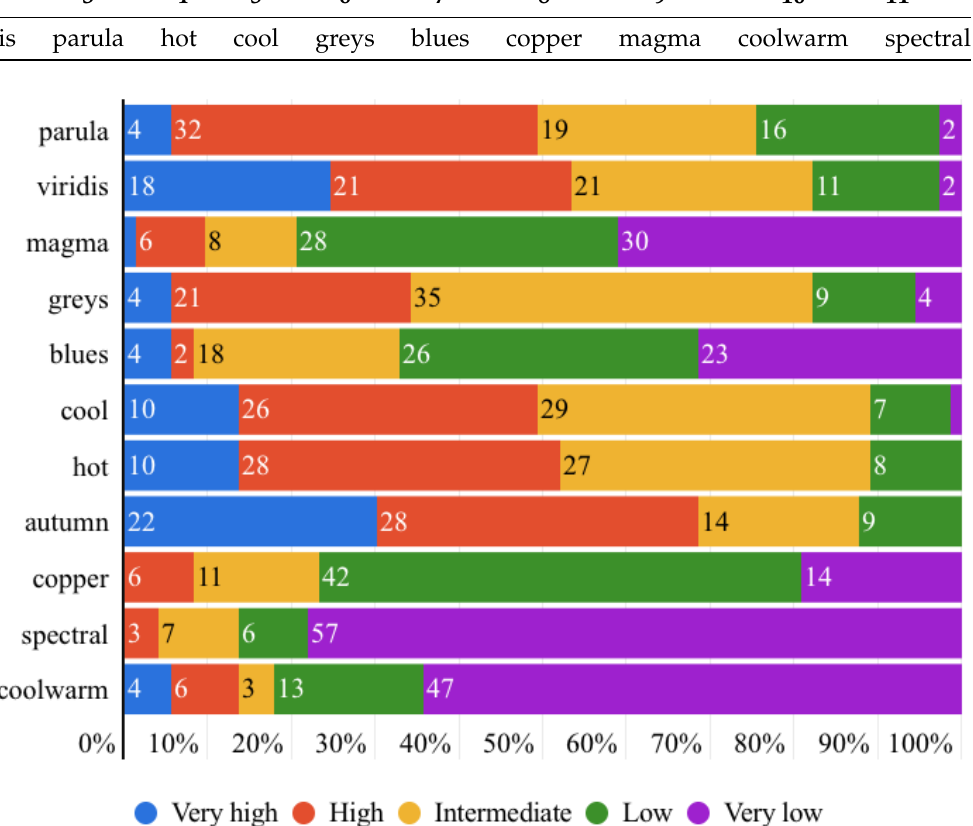
Table 4. The holistic accuracy rankings (high to low) of the 11 colormaps obtained from study part 2. Ranks